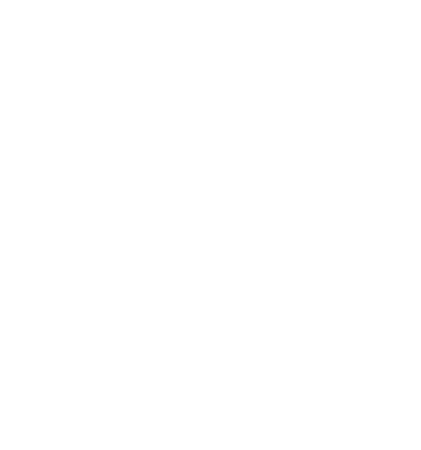
Figure 7. Trends in validation accuracy for transfer learning on ResNet50 with seven different activation functions.